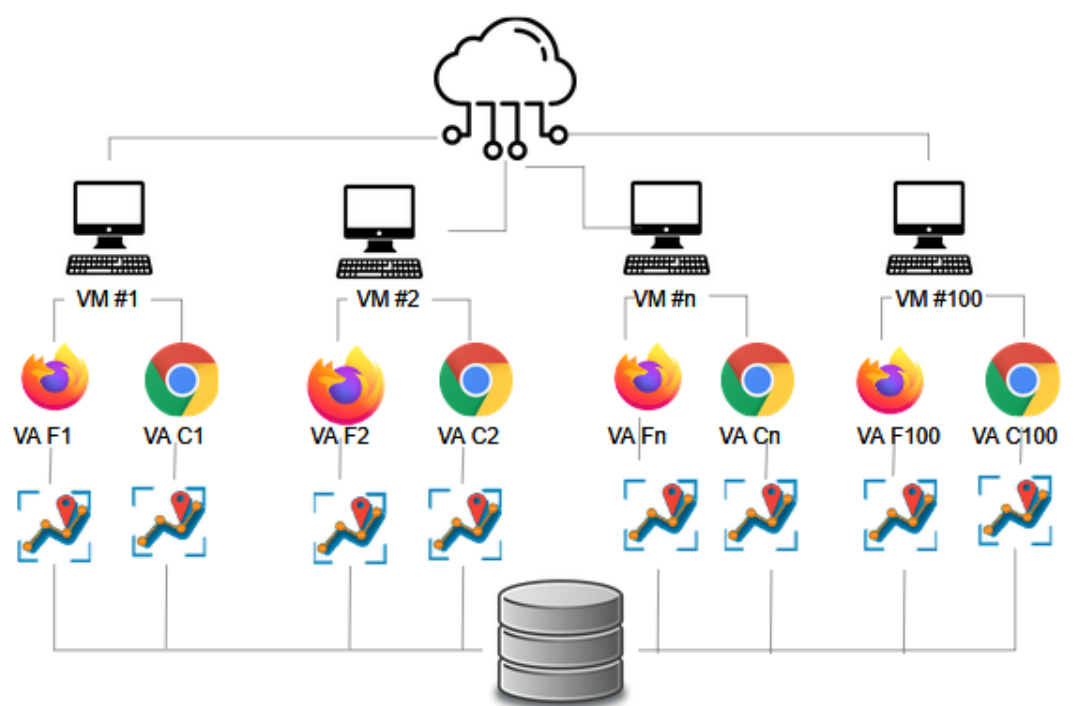
Figure 5. Data collection infrastructure